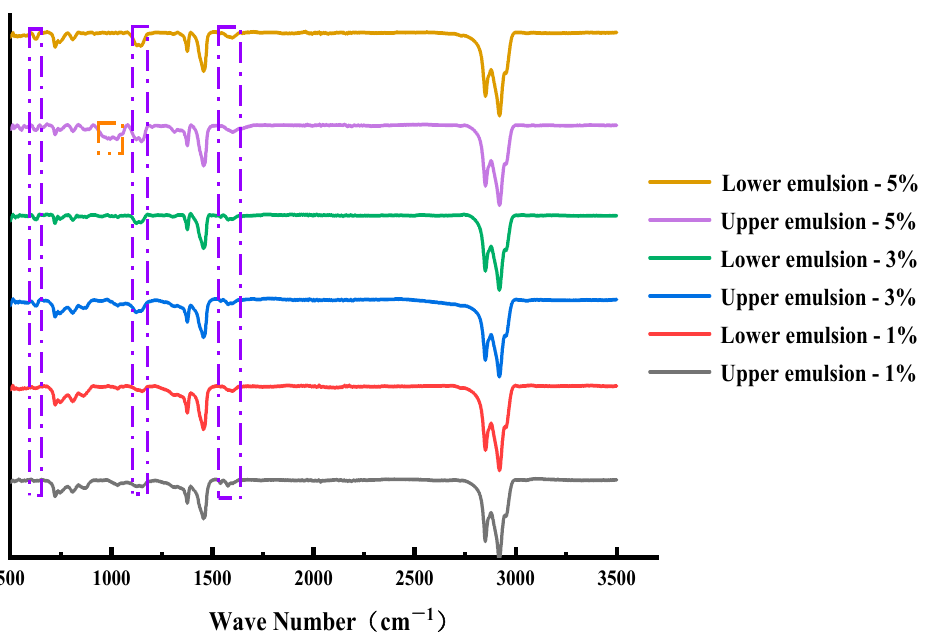
Figure 10. Infrared spectra of bio-oil asphalt/water emulsion at different layers with different emulsifier contents (The purple dashed line represents the main characteristic peak changes occurring in the emulsified asphalt relative to the matrix asphalt).